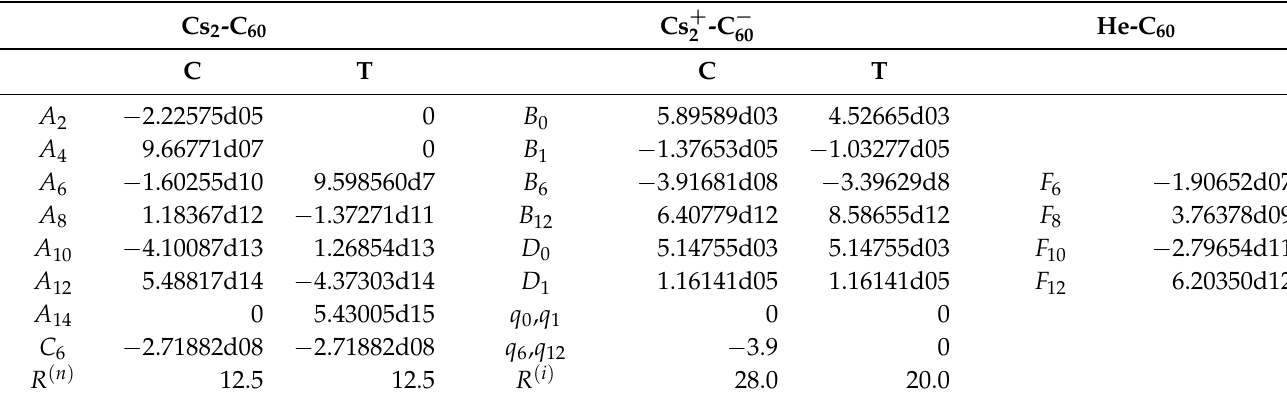
Table 1. Parameters defining the analytical description of the Cs 2 -C 60 and Cs + (T) arrangements, Equation (6), as well as the He-C 60 interaction, Equation (4). Energies and distances are given in cm − 1 and Å, respectively. These global units determine those corresponding to the different parameters. For instance, the unit of the C 6 coefficient parameter is cm − 1 Å 6